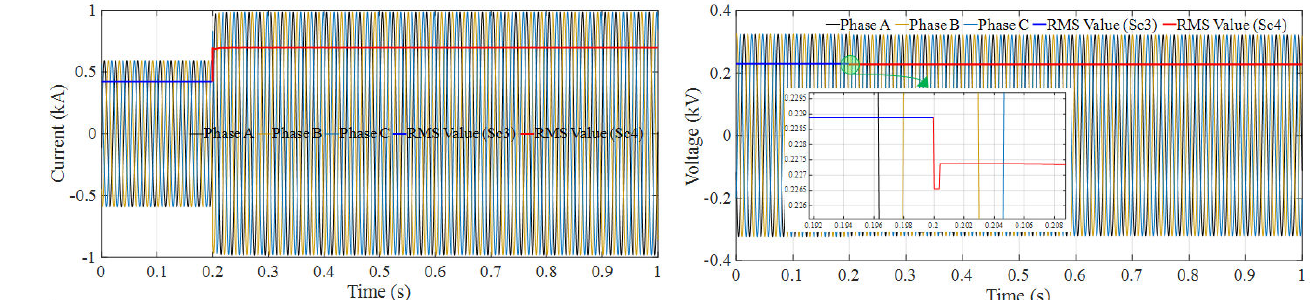
Figure 24. Voltage and current signals at the transformer secondary side for scenario 3 and scenario 4.